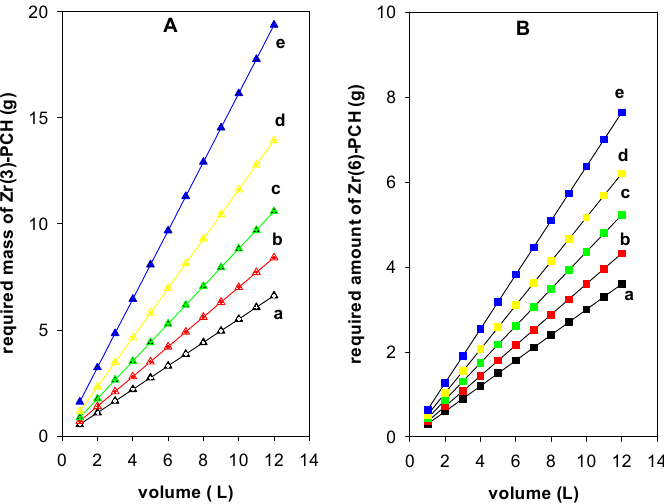
Figure 10. Prediction of the required amount (g) of (Zr(3) ‐ PCH material ( A ) and Zr(6) ‐ PCH ( B